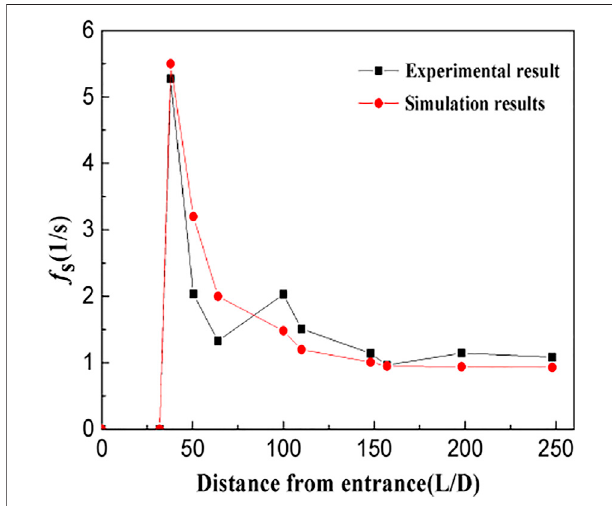
FIGURE 10 | Comparison between simulations and experiments of slug frequency along the fl ow direction ( V sg (cid:2) 3 m/s, V sl (cid:2) 1 m/s).